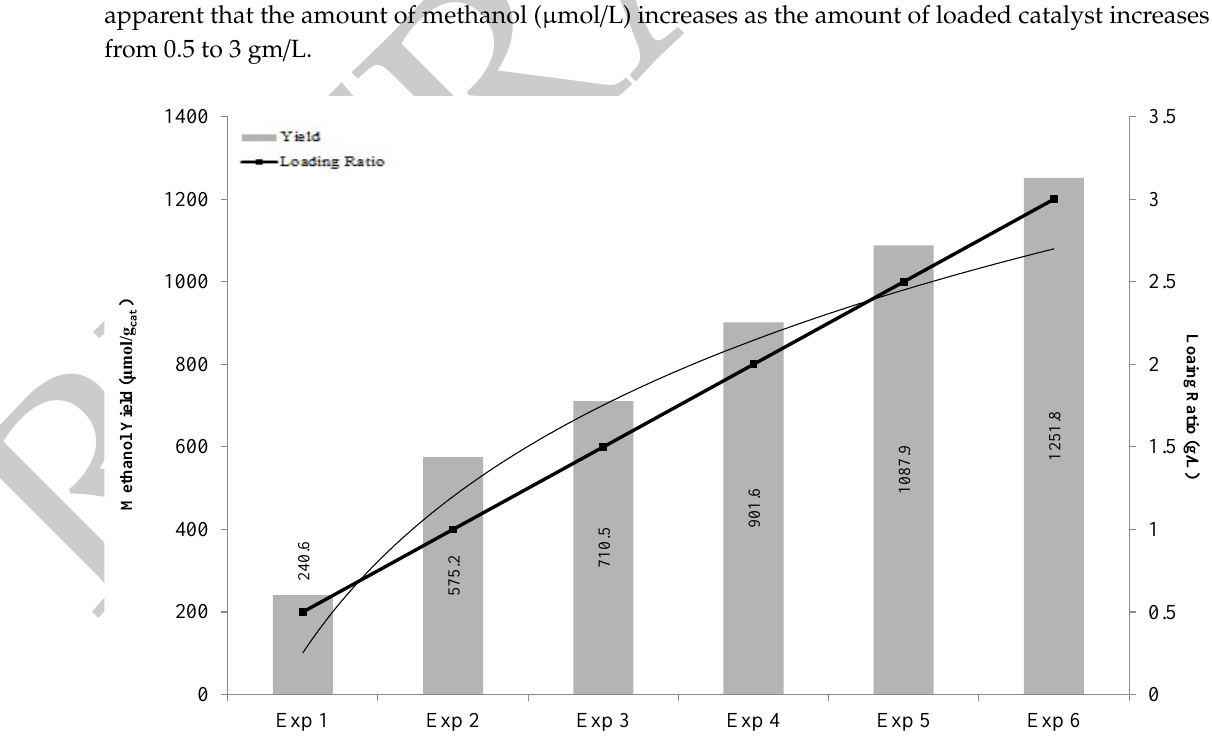
Figure 8. Effect of different catalyst loading ratios on the yield of methanol.